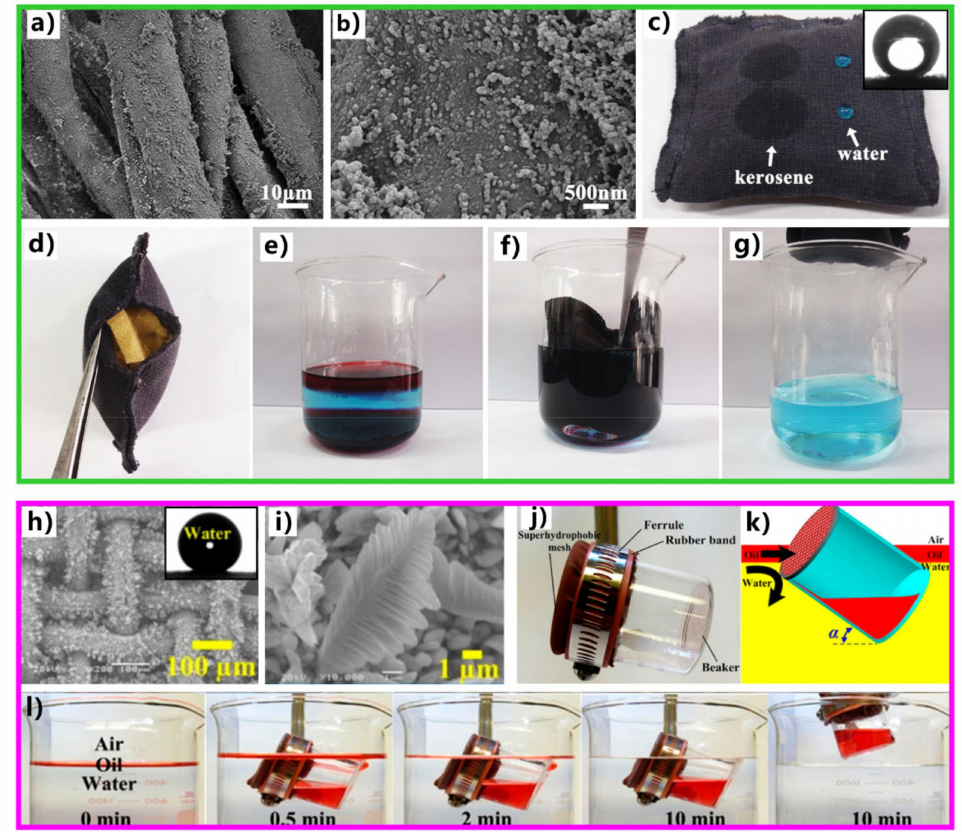
Figure 19. Transforming superhydrophobic 2D porous mesh/membrane into 3D oil-absorption mate- rials. ( a – g ) Superhydrophobic and superoleophilic oil-absorption cloth bag: ( a ) surface microstructure of the nanoparticles-coated fabric, ( b ) microstructure on the fabric surface, ( c ) drops of water and oil (kerosene) on the cloth bag (inset: water droplet on the superhydrophobic fabric), ( d ) Photo of